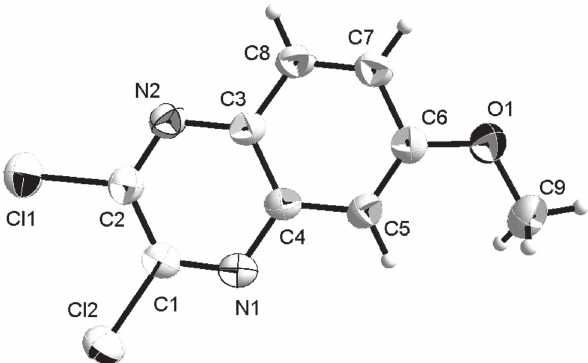
Table 1: Data collection and handling.